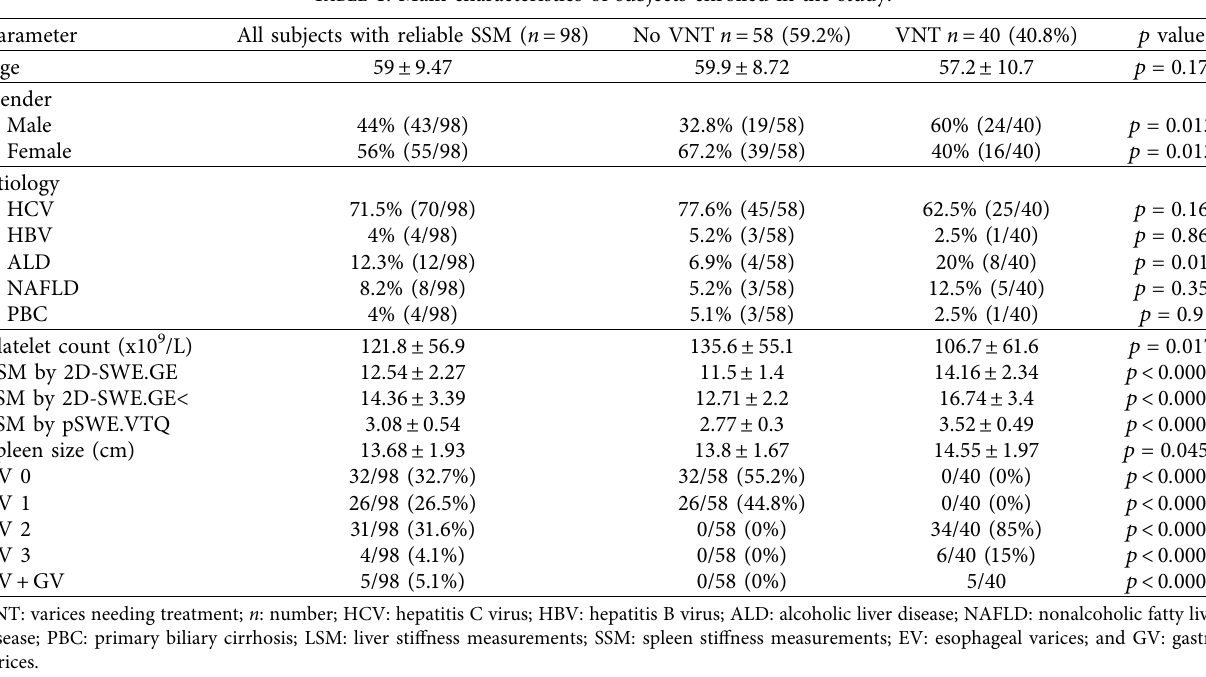
Figure 1: Characteristics of subjects enrolled in the study. Table 1: Main characteristics of subjects enrolled in the study.